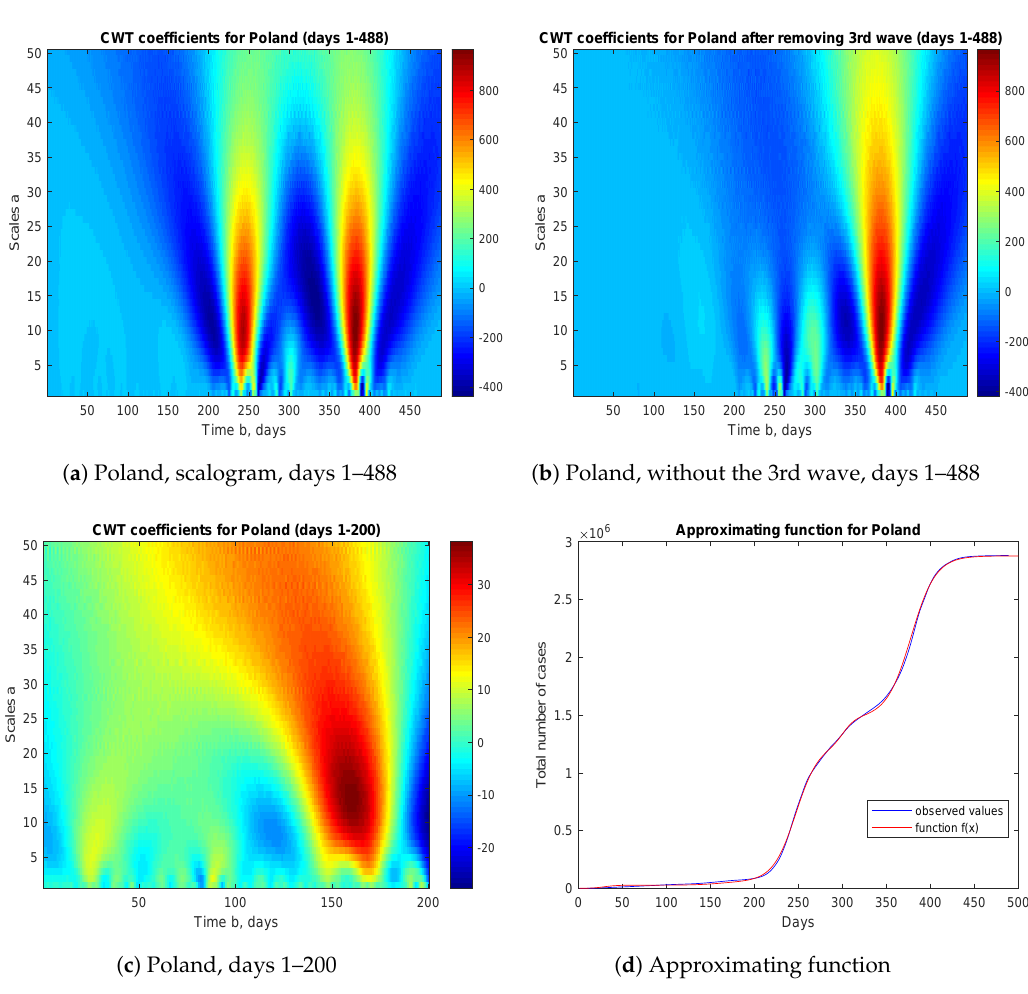
Figure 4. Scalograms and the approximating multilogistic function (25) for